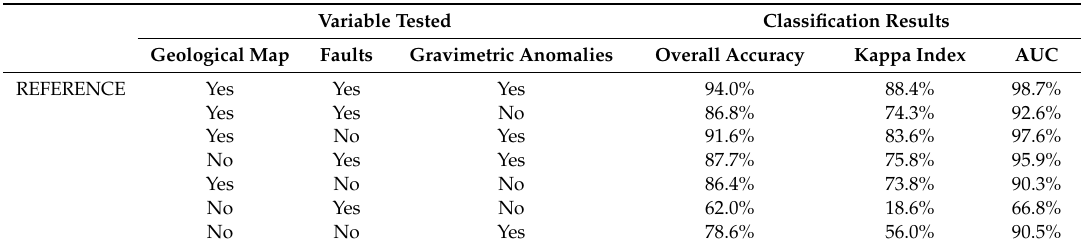
Table 6. Sensitivity analysis. Results of a k -fold cross-validation ( k = 10) of a random forest classification (depth = 8 and number of trees = 100).